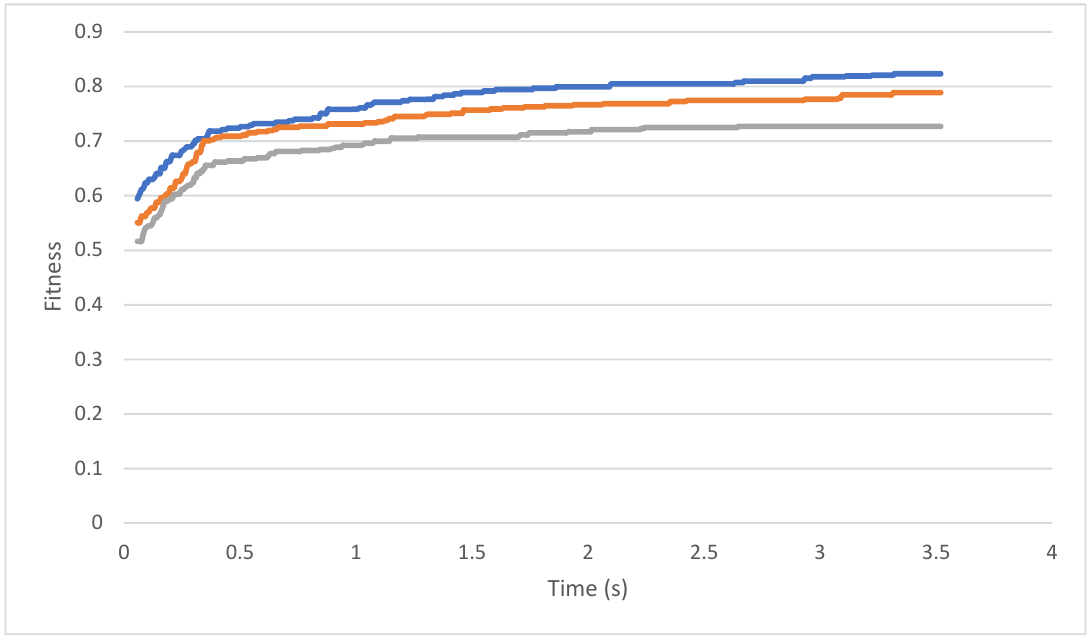
Figure 8. Fitness evolution examples.